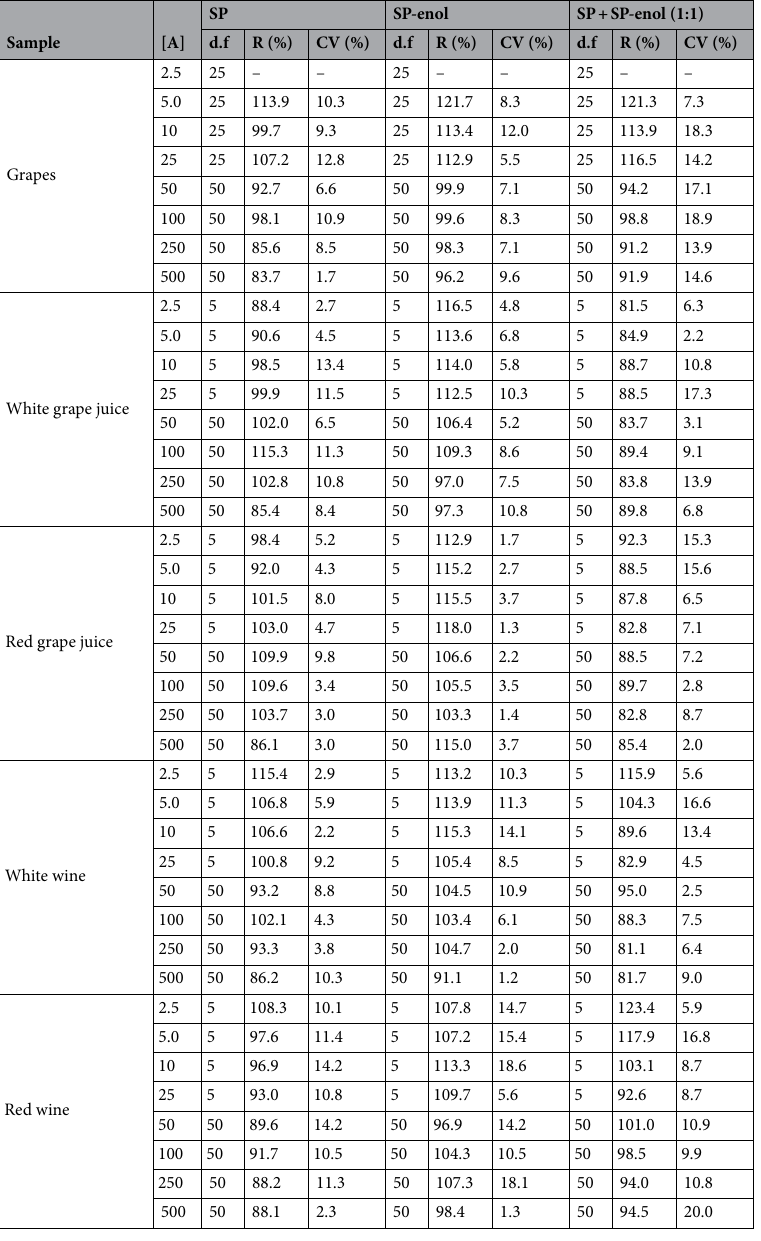
Table 4. Recovery values (as SP-enol) and coefficients of variation obtained with fortified samples by the developed direct cELISA (n = 3). [A], analyte concentration in μg/L; d.f., sample dilution factor in NaOH; R, recovery values. –, out of